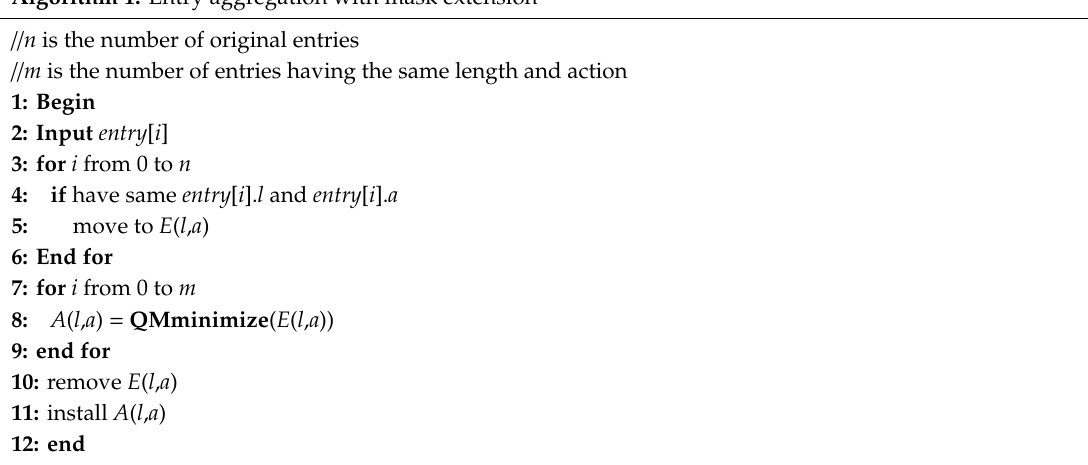
Table 3. An example table.